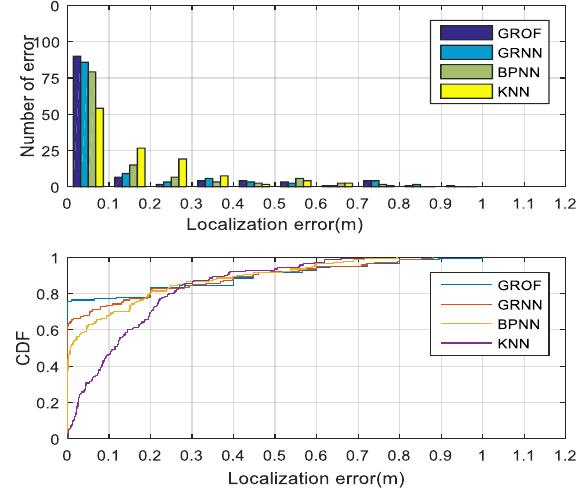
Figure 18. Localization error histogram and CDF of different algorithm in NLOS Case 2.